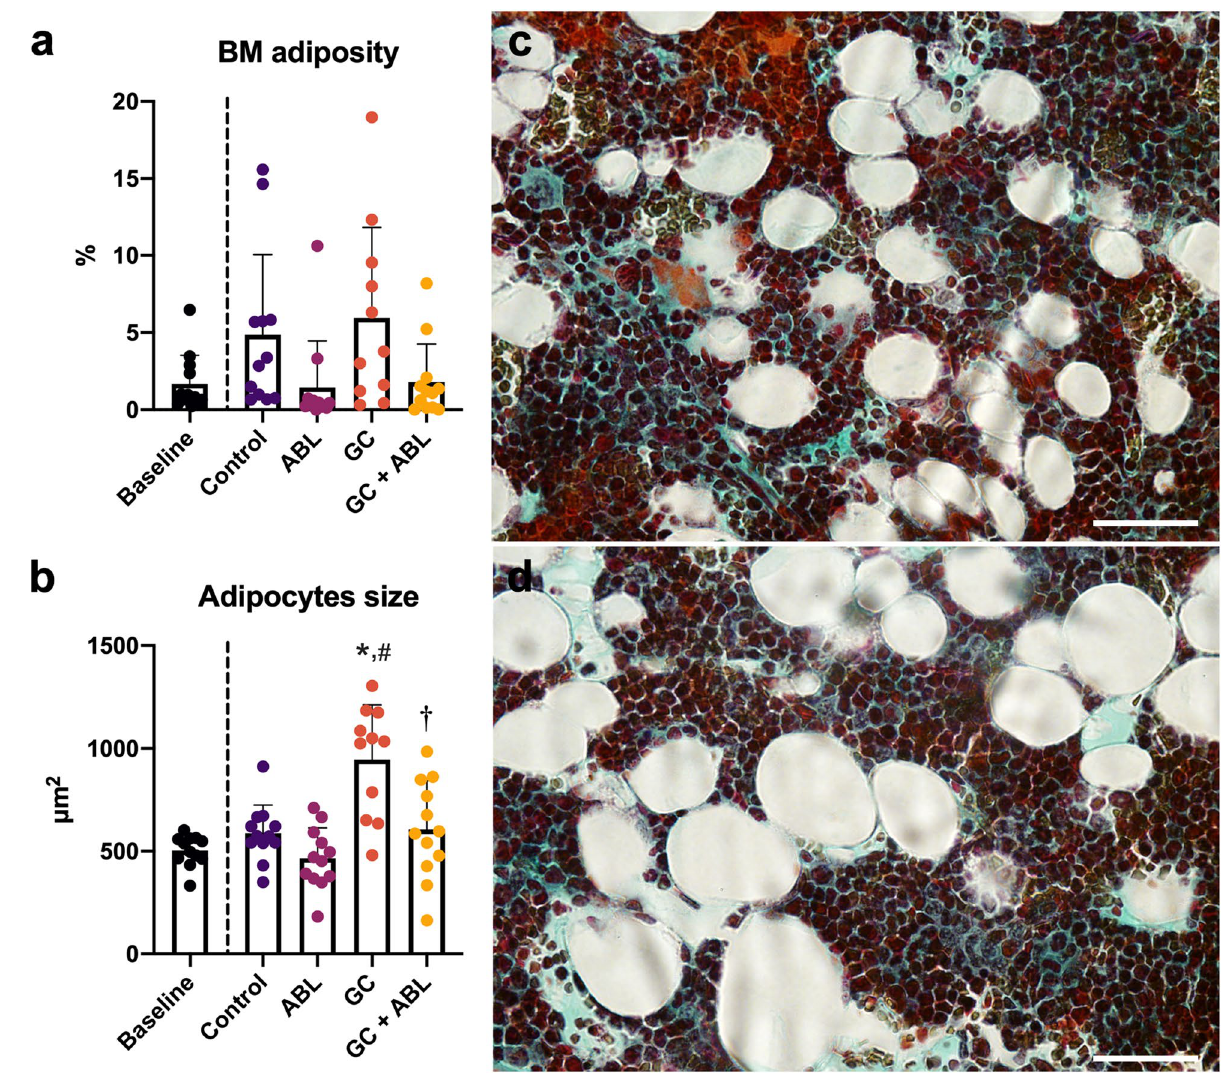
Figure 6. ( a ) Bone marrow (BM) adiposity, ( b ) average size of adipocytes, and ( c , d ) representative Masson– Goldner trichrome-stained histological sections from the distal femoral metaphysis showing adipocyte size from an animal in the Control group and GC group, respectively. Bar = 100 µm. Mean ± SD. * p < 0.05 vs. Control. # p < 0.05 vs. ABL. † p < 0.05 vs.